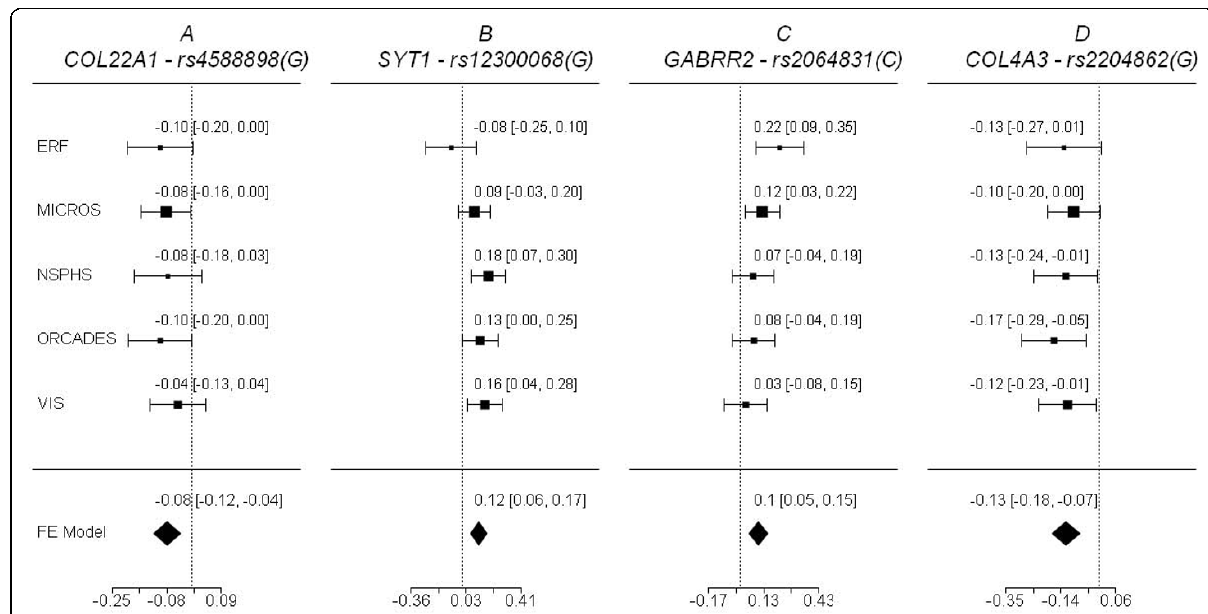
Figure 4 Forest plots of betas and standard errors, with 95% confidence intervals, for the most significant SNPs in the three replicated loci (A, B, and C) and for the most significant SNP of the discovery meta-analysis (D) . The pooled estimate was obtained